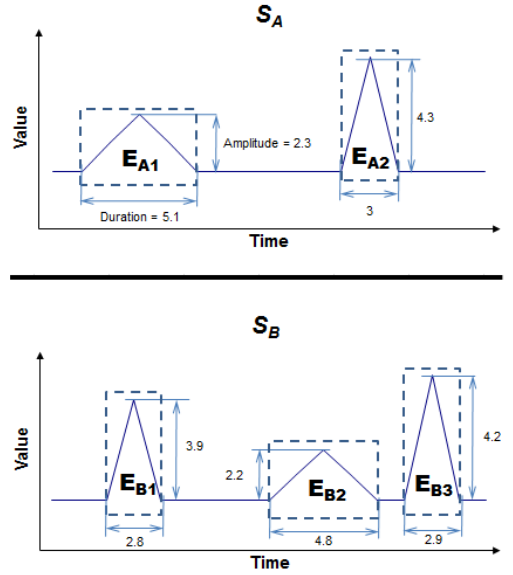
Figure 1. Charts showing two time series and event